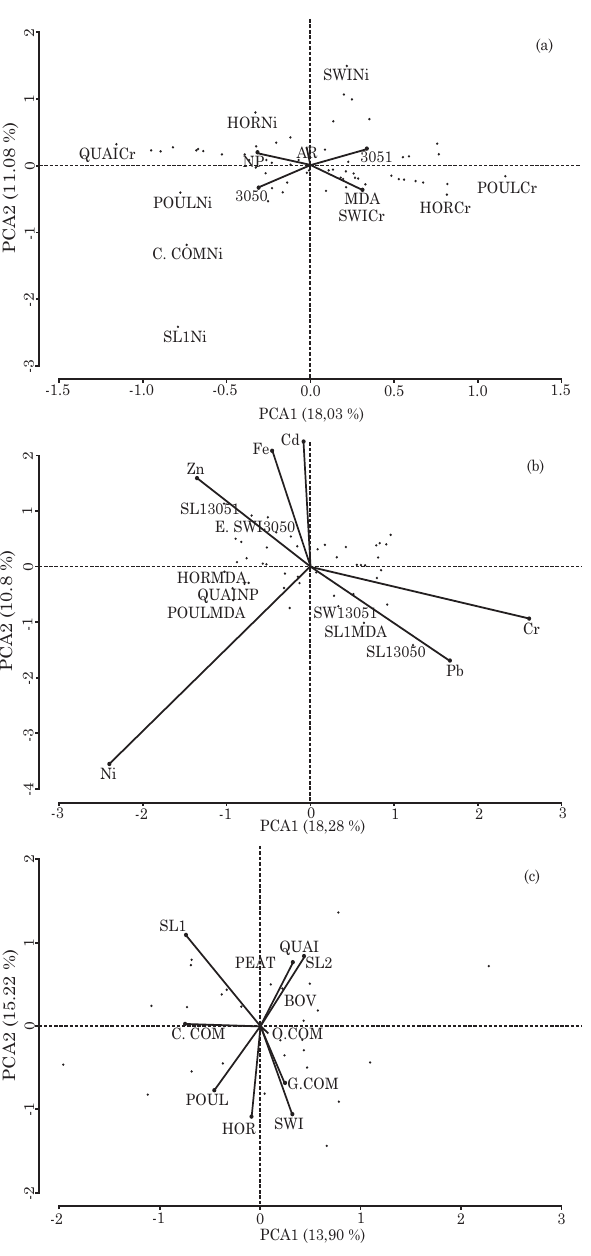
Figure 2 Conditional joint biplot in which (a) Organic residues × TEs is a function of DMs, (b) Organic residues × DMs is a function of TEs and (c) TEs × DMs is a function of Organic residues. The residues evaluated were commercial compost (C.COM), garbage compost (G.COM), organic compost (O.COM), cattle manure (BOV), quail manure (QUAI), horse manure (HOR), chicken manure (CHIC), swine manure (SWI), sewage sludge 1 (SL1), sewage sludge 2 (SL2) and peat (PEAT). The TEs analyzed were Cd, Cr, Fe, Ni, Pb and Zn by digestion methods EPA 3051A (3051), nitric- perchloric (NP), modified dry ashing (MDA), aqua regia (AR) and EPA 3050